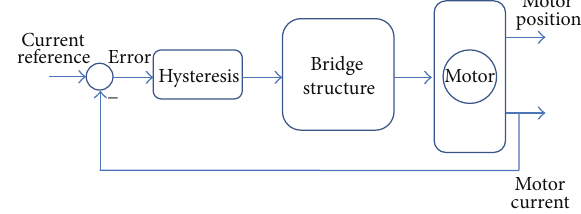
Figure 14: Control scheme using hysteresis controller in the